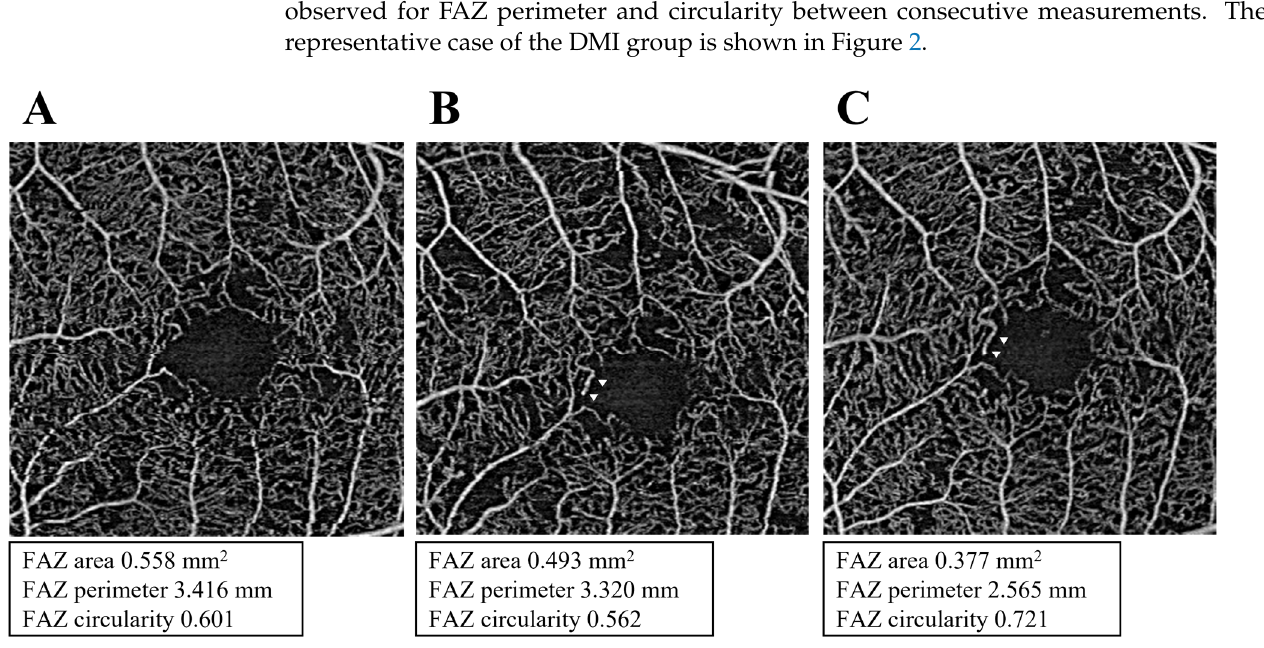
Figure 2. Representative case of the diabetic macular ischemia (DMI) group. ( A ) At baseline, the eye had a large foveal avascular zone (FAZ) with a FAZ area ≥ 0.5 mm 2 , which was diagnosed as DMI. FAZ area was reduced due to local capillary revascularization (white arrowhead) within the FAZ at 1 ( B ) and 3 ( C ) months following panretinal